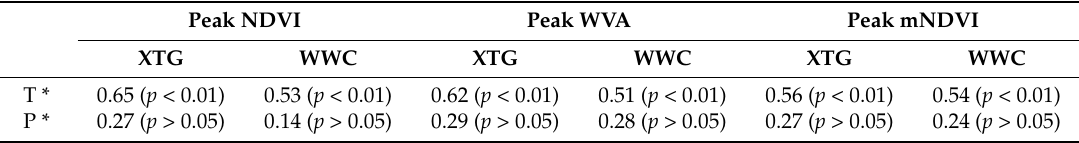
Table 4. The correlation coefficients (r) between the wetland vegetation characteristics at the XTG and WWC and the annual mean temperature and annual precipitation in the YNNR during 1988–2016. Peak NDVI Peak WVA Peak mNDVI XTG WWC XTG WWC XTG WWC T * 0.65 ( p < 0.01) 0.53 ( p < 0.01) 0.62 ( p < 0.01) 0.51 ( p < 0.01) 0.56 ( p <